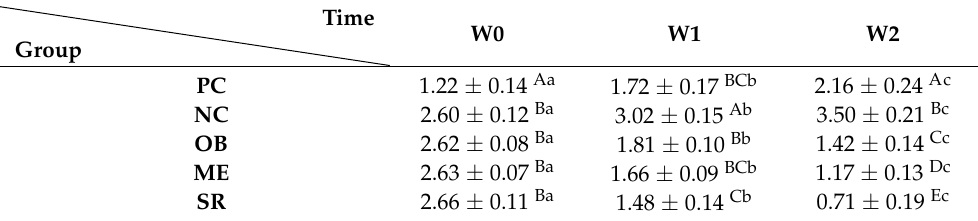
Table 2. Average skin recovery time after each week of treatment.